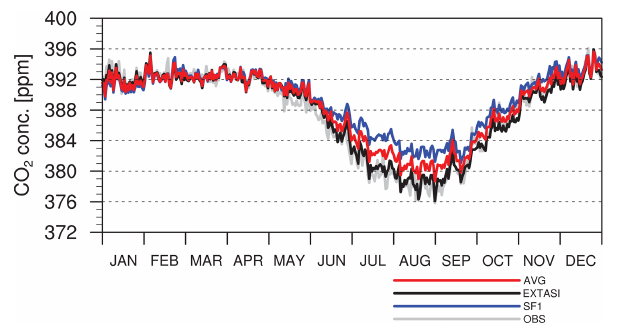
Figure 2. Time series of CO 2 concentration from hypothetical ob- servations, model simulations, and real observations. The gray solid line (OBS) denotes the value of real observation data, the black solid line indicates the value from the EXTASI experiment, the blue solid line denotes the value of the SF1 experiment, and the red solid line (AVG) denotes the average of the EXTASI and SF1, which was re- garded as TRUE observation data in this